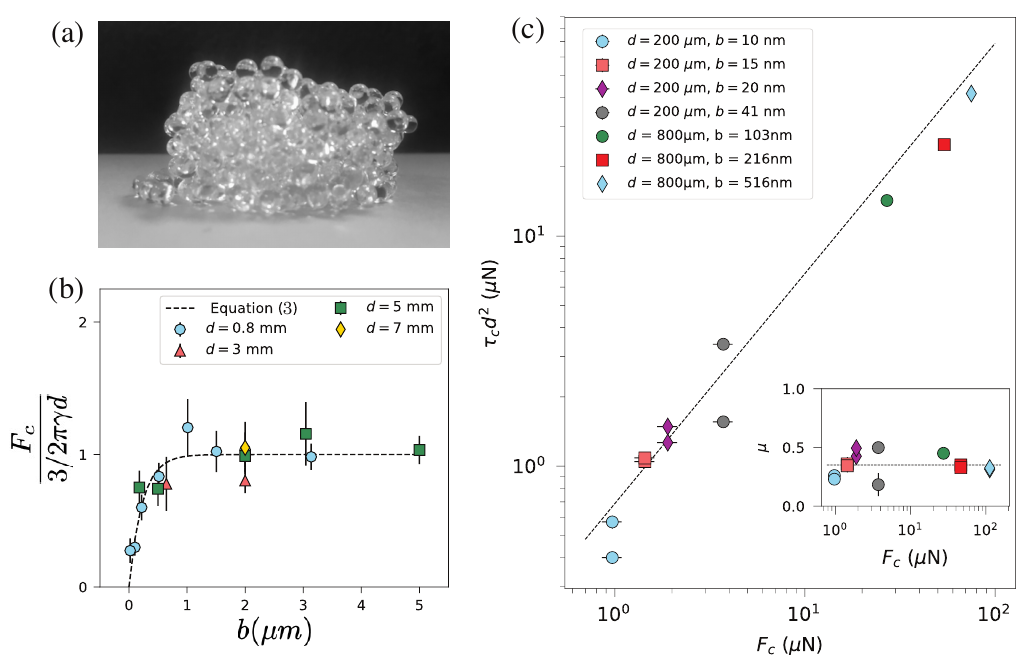
Figure 5. (a) Example of a cohesion-controlled granular material: a pile of glass beads d = 3mm with a PBS coating layer of thickness b = 2 . 2 µ m;(b) Adhesion force between two particles normalized by the capillary scaling eq. 2 as a function of the averaged coating thickness b ; (c) Cohesive stress times the particle diameter τ c d 2 as a function of the adhesion force F c , τ c being deduced from measurements of the starting angle on an inclined